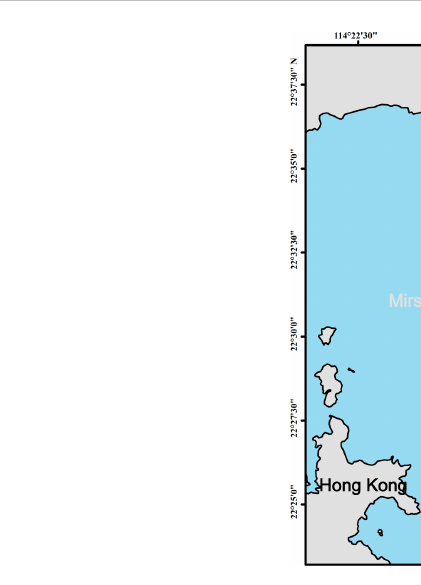
FIGURE 1 Sampling stations ( ● ) in Mirs Bay during the phaeocystis globosa